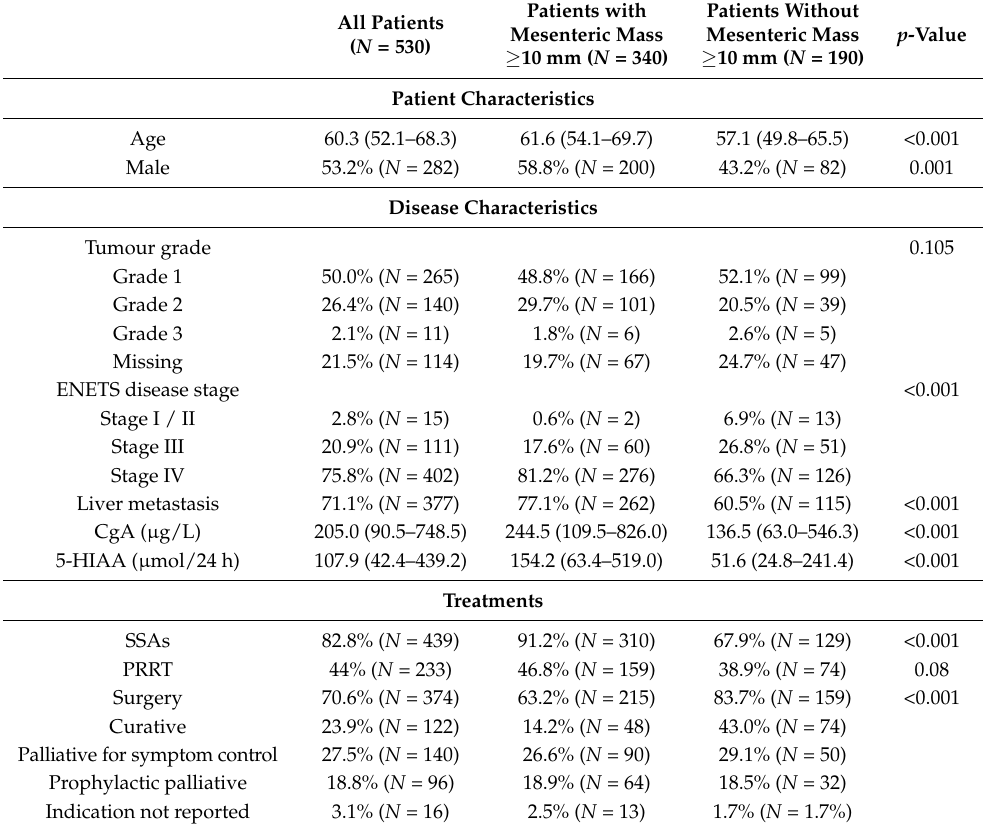
Table 1. Characteristics.